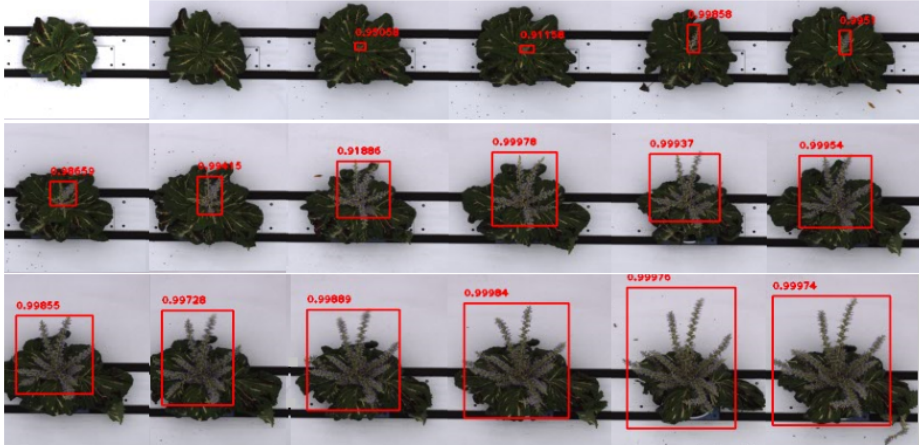
Figure 15. Illustration of flower emergence timing detection and its growth over consecutive days (following left to right direction) using a sample Coleus image sequence (D2) for the top view starting from Day 16 ( top-left ) to Day 33 ( bottom-right